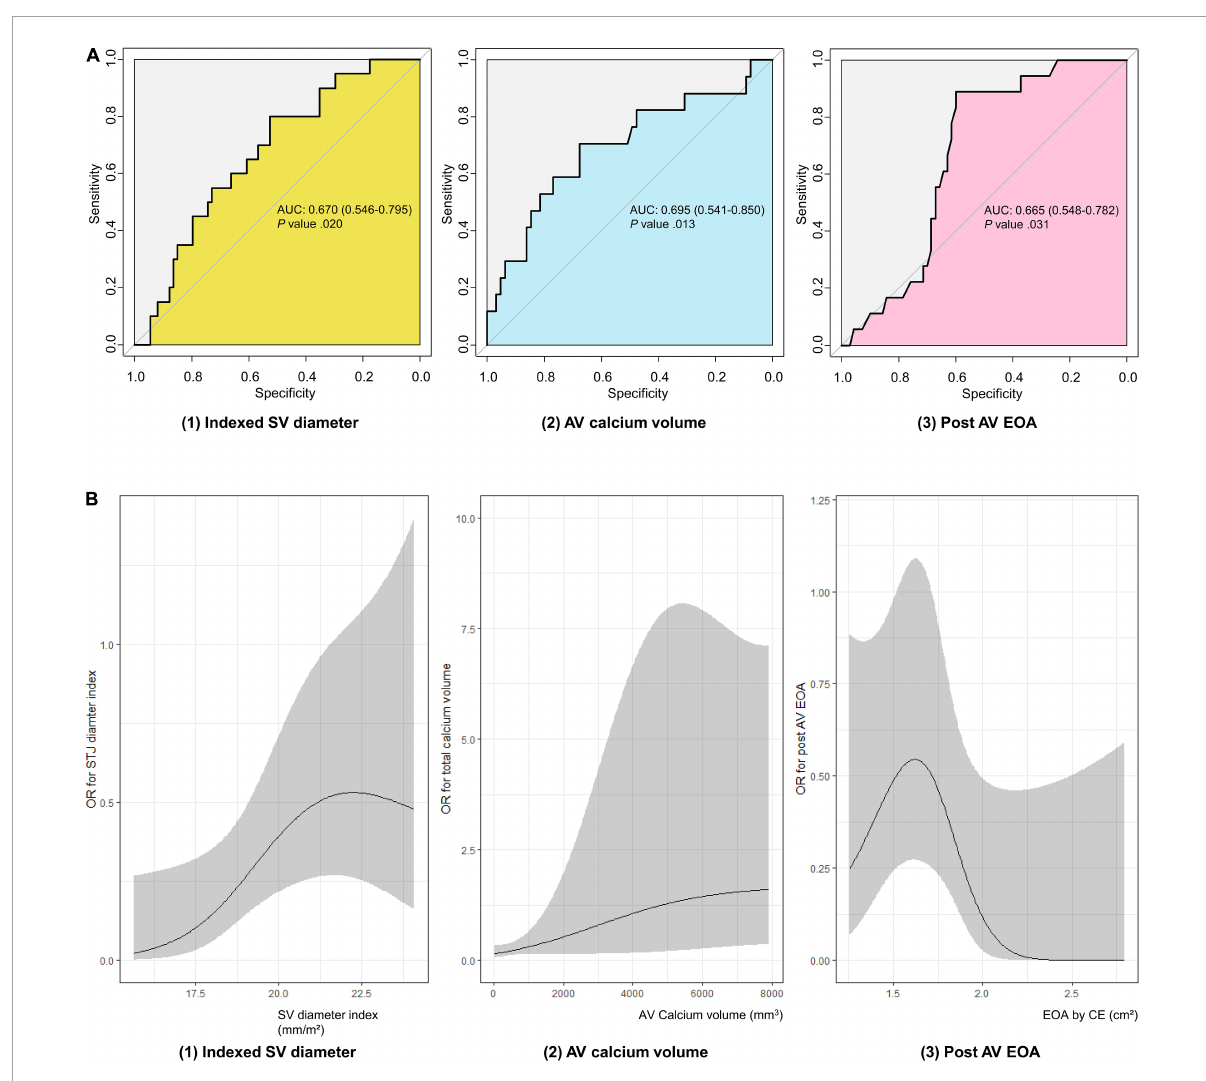
FIGURE2 Evaluation of subclinical leaflet thrombosis risk factors in TAVR patients. (A) ROC curve of subclinical leaflet thrombosis risk factors. (B) Spline curve of subclinical leaflet thrombosis risk factors. AUC, area under curve; AV, aortic valve; EOA, estimated orifice area; OR, odds ratio; ROC, receiver operating characteristic; SOV, sinus of Valsalva; TAVR, transaortic valve